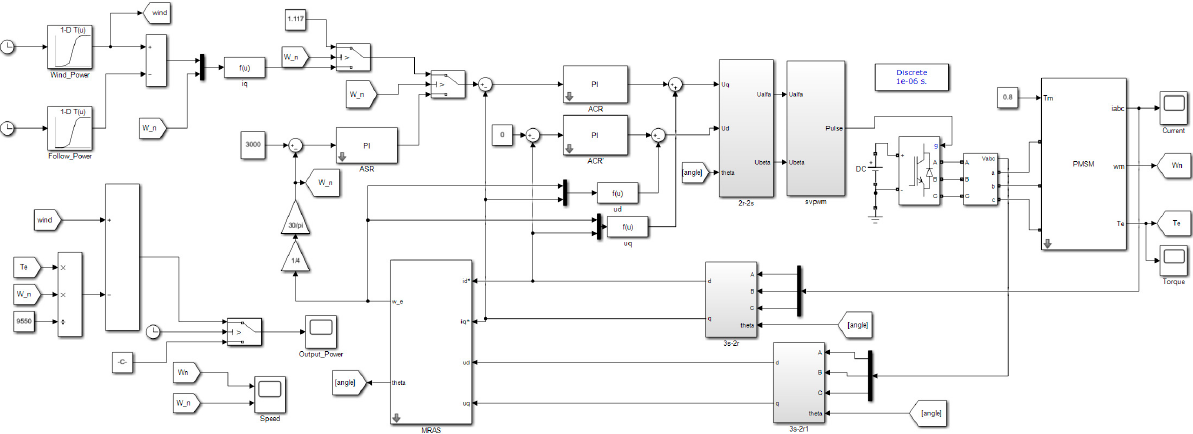
Figure 7. Power compensation simulation model of FESS.